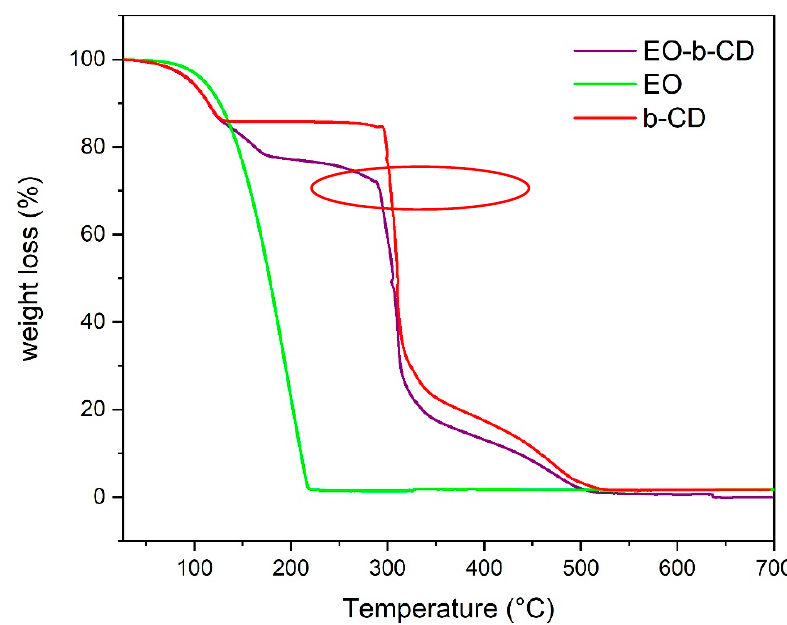
Figure 3. TGA profile of b-CD (red), EO (green), and of the EO-b-CD complex (purple).